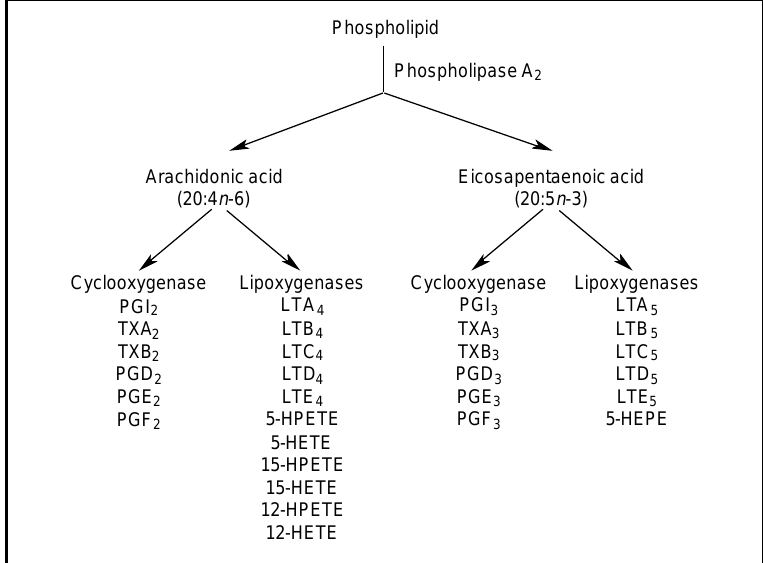
Figure 2 - Synthesis of eicosanoids from arachidonic and eicosapentaenoic acids. HEPE indicates hydroxyeicosapentaenoic acid; see text for explanation of other